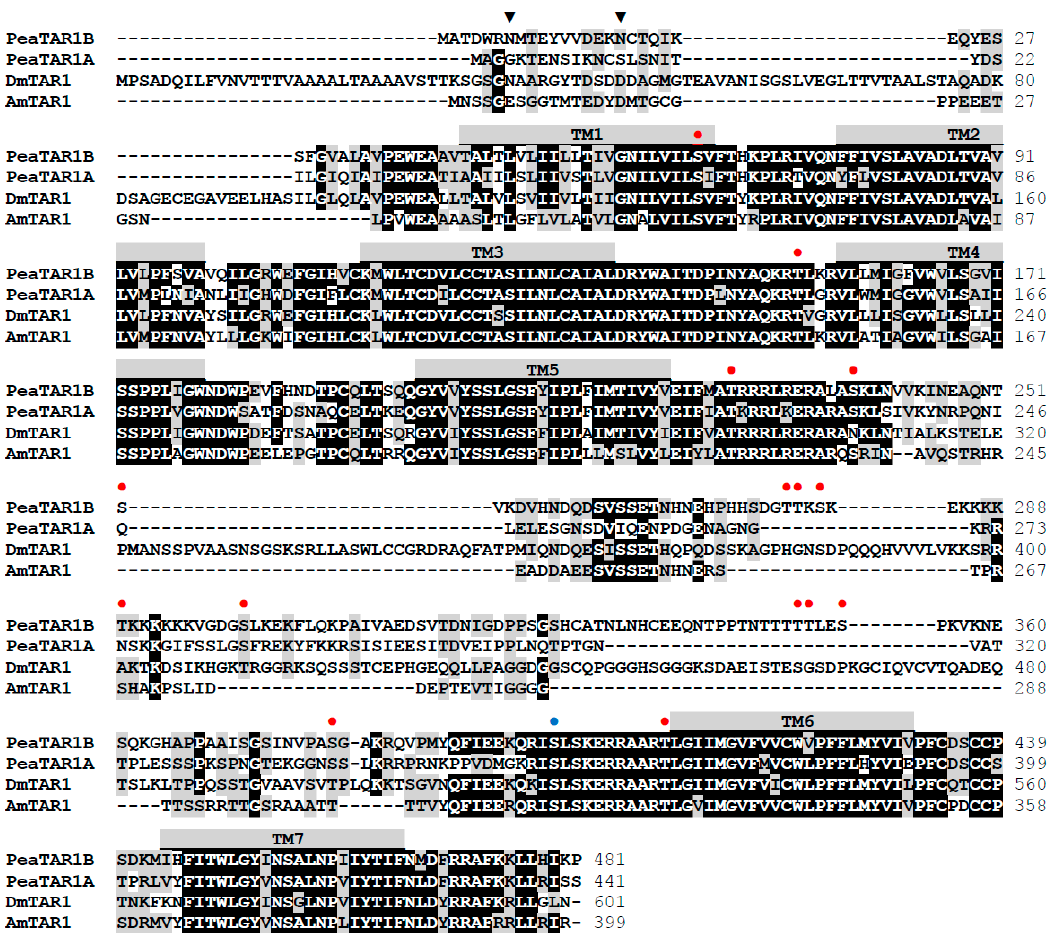
Figure 2. Amino acid sequence alignment of PeaTAR1B and orthologous receptors from Periplaneta americana (PeaTAR1A, CAQ48240.1), Drosophila melanogaster (DmTYR1; NP_524419.2), and Apis mellifera (AmTAR1, NP_001011594.1). Identical residues ( ≥ 75%) are shown as white letters against black, whereas conservatively substituted residues are shaded. Putative transmembrane domains (TM1–TM7) are indicated by gray bars. Potential N -glycosylation sites ( ▼ ), protein kinase A (PKA) phosphorylation sites ( ● ), and protein kinase C (PKC) phosphorylation sites ( ● ) of PeaTAR1B are indicated. The amino acid position is given on the right.